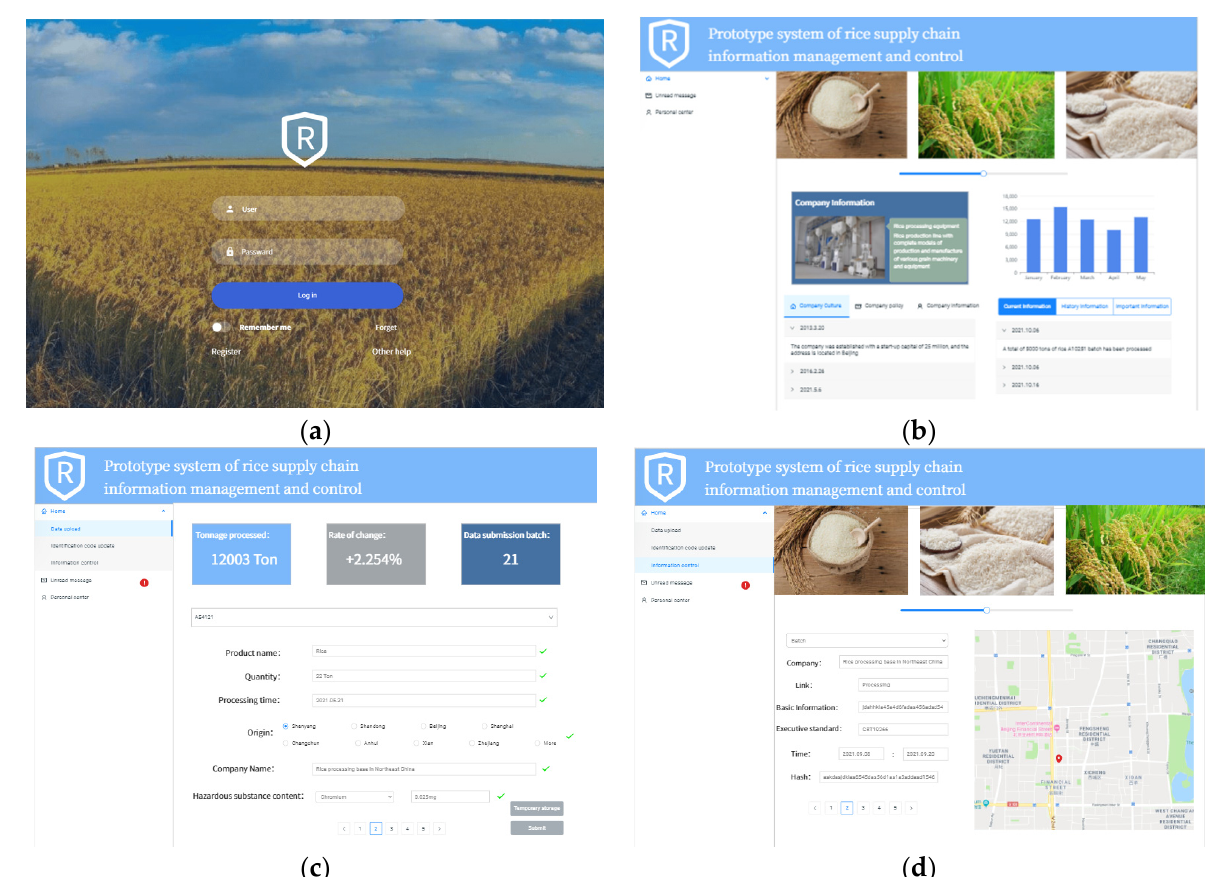
Figure 8. Schematic diagram of the prototype system interface: ( a ) Schematic diagram of the login screen; ( b ) Schematic diagram of the main page; ( c ) Schematic diagram of the data upload interface; ( d ) Schematic diagram of the trusted supervision interface.